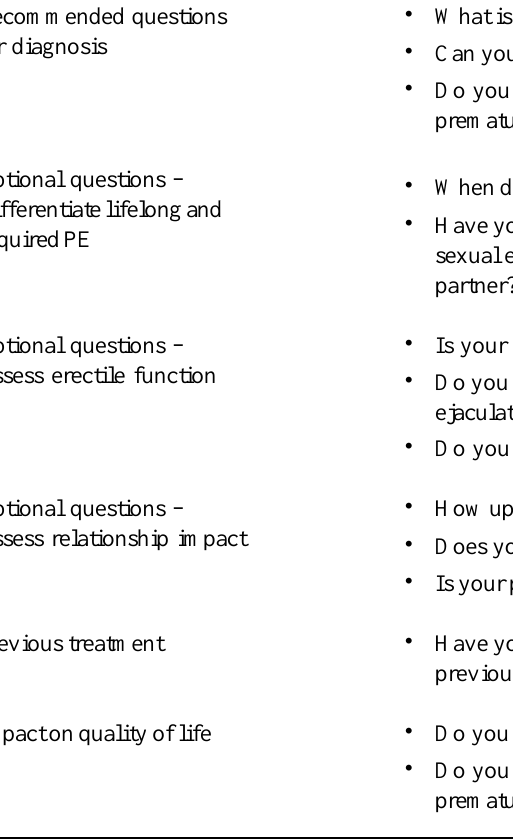
Table 1. Useful questions in clinical